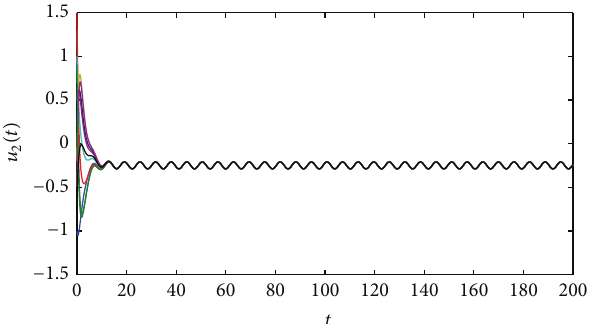
Figure 9: Transient response of state variables 𝑢 3 (𝑡) of Example 2.